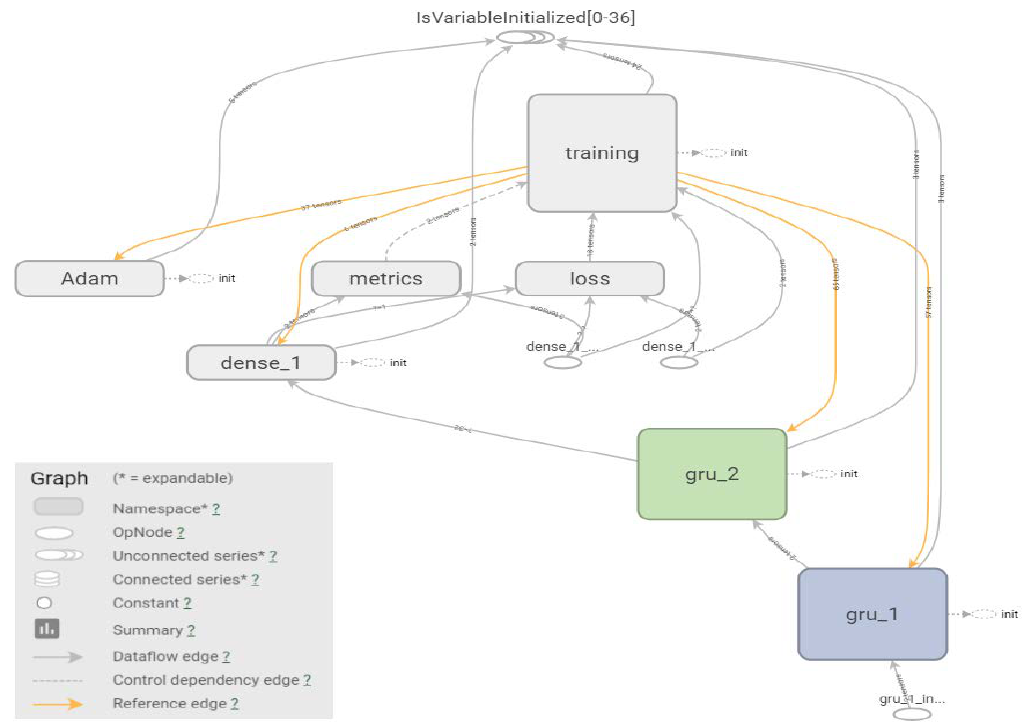
Figure 7. TensorFlow computation graphs of the network structure of proposed model. This figure illustrates the data dependencies and control dependencies. The solid arrows indicate the data dependencies that show the flow of tensors between two ops, while dotted lines indicate the control dependencies.